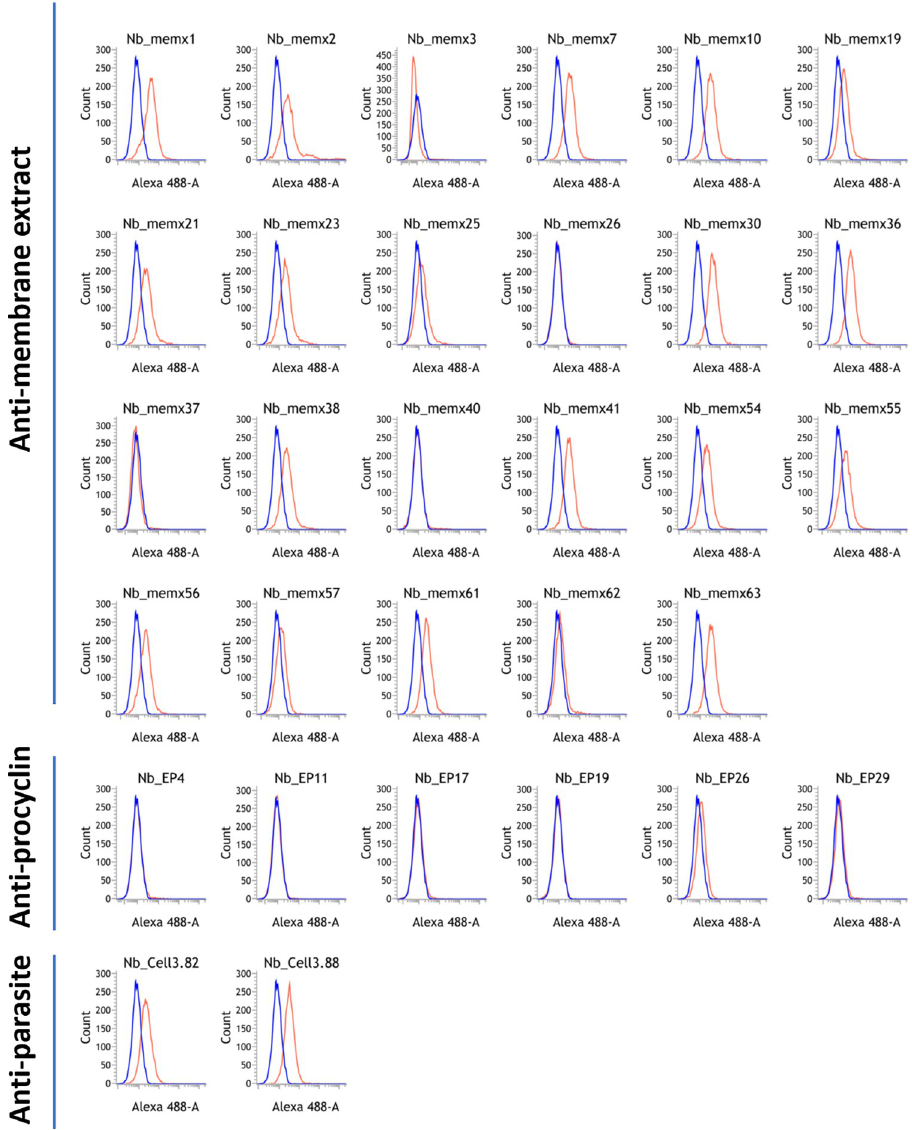
Fig 2. Binding of individually purified anti-procyclic Nbs onto fixed procyclic T . b . brucei . The red histograms indicate staining with the respective anti-procyclic Nbs and detection using an Alexa Fluor 488 labeled anti-HA tag antibody. A non-procyclic-specific Alexa488-labelled control nanobody (cAb-BCII-10) did not significantly bind to the trypanosome surface (blue histogram). (S1 Fig) and recombinant S . glossinidius strains showed growth kinetics comparable to a WT S . glossinidius strain (S2 Fig). Since protein expression of Nb_63 could not be detected using Western blot analysis, rec Sodalis ::Nb_63 was removed from further in vivo analysis.